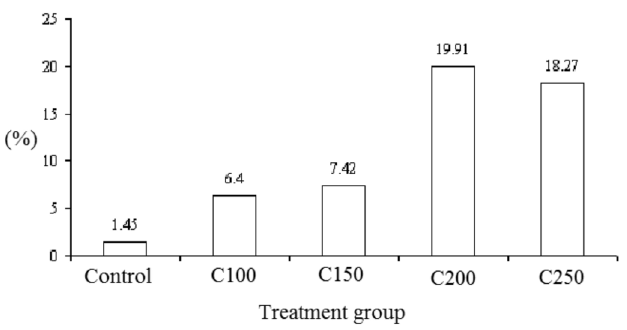
FIGURE 2 – Rate of abnormal spermatozoids in every experimental and control group. C100 cyclophosphamide 100 mg.kg -1 , C150 cyclophosphamide 150 mg.kg -1 , C200 cyclophosphamide 200 mg.kg -1 , C250 cyclophosphamide 250 mg.kg